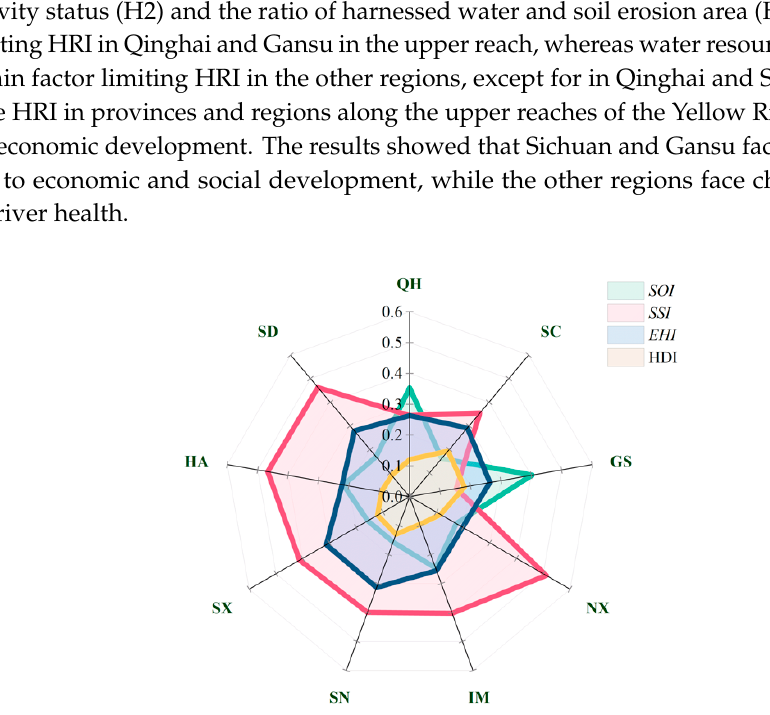
Figure 10. The degrees of limitation of the four dimensions to the Happy River Index (HRI) at the regional scale along the Yellow River. Here, the labels “QH”, “SC”, “GS”, “NX”, “IM”, “SN”, “SX”, “HA”, and “SD” refer to the provinces and regions of Qinghai, Sichuan, Gansu, Ningxia, Inner Mongolia, Shaanxi, Shanxi, Henan, and Shandong, respectively.